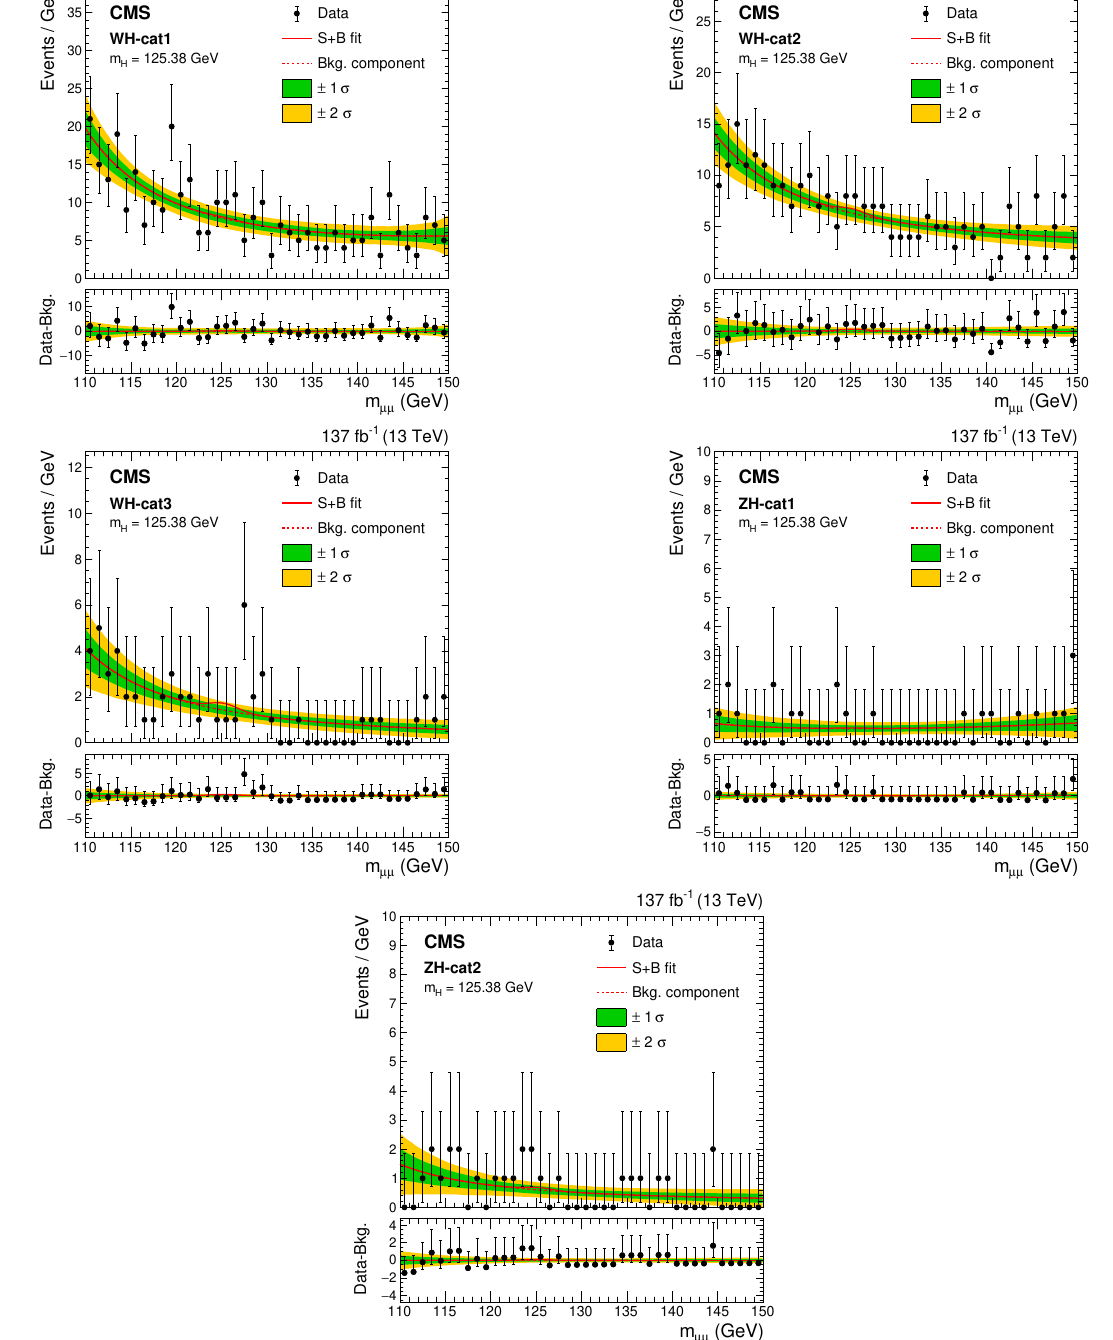
Figure 9 . Comparison between the data and the total background extracted from a S+B fit performed across the various WH and ZH event subcategories. The one (green) and two (yellow) standard deviation bands include the uncertainties in the background component of the fit. The lower panel shows the residuals after the background subtraction, where the red line indicates the signal with m = 125 . 38 GeV extracted from the H